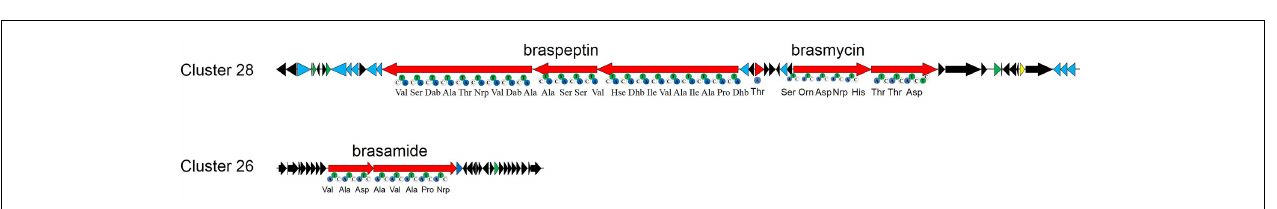
FIGURE 2 | The CLP gene clusters of Pseudomonas sp. 11K1. CLPs are synthesized by modular non-ribosomal peptide synthases (NRPSs), and each module contains an adenylation (A), condensation (C), and thiolation (T) domain. Red arrows indicate biosynthetic genes, blue arrows indicate transport-related genes, green arrows indicate regulatory genes, the yellow arrow indicates a predicted transposase, and other genes are indicated by black